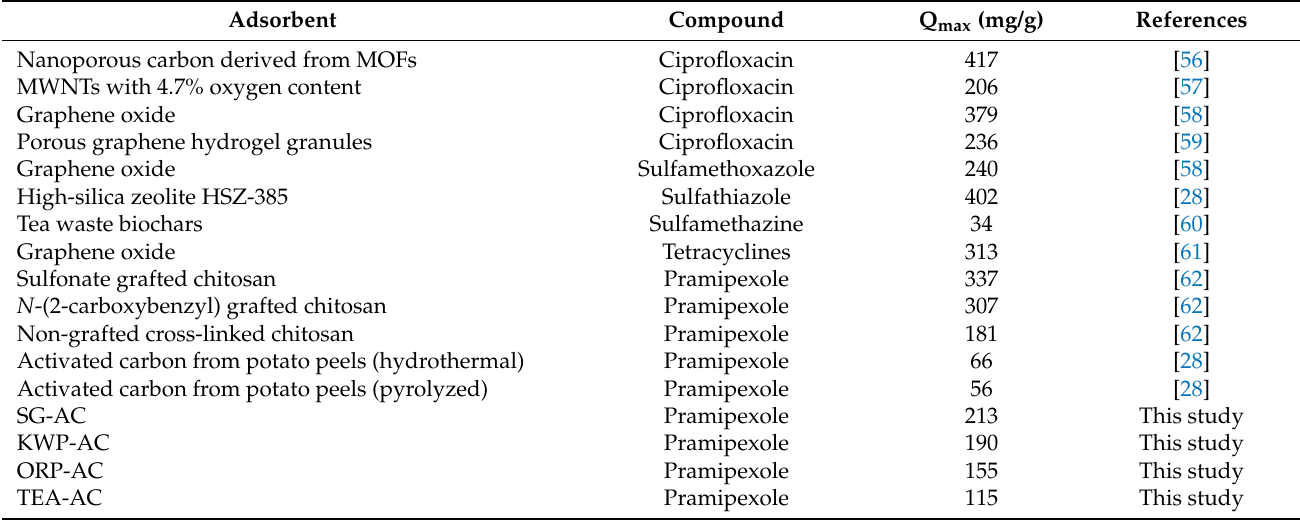
Table 5. Maximum adsorption capacities of different adsorbent materials for the removal of pharmaceuticals from aque- ous